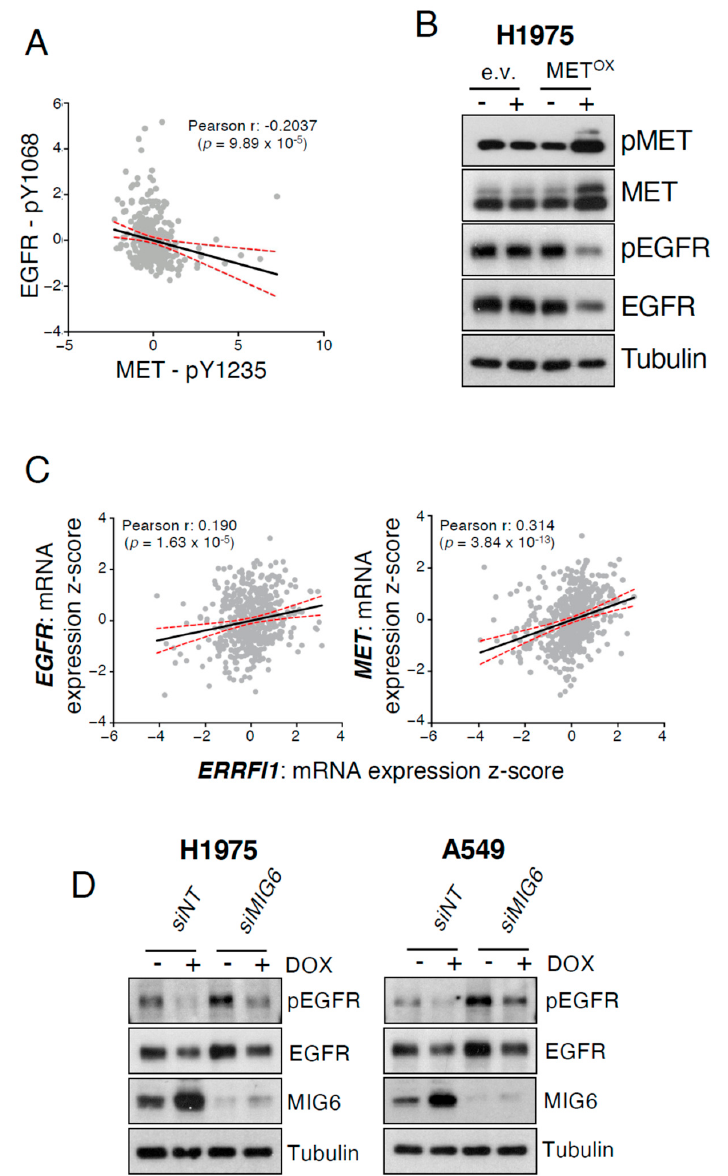
Figure 2. MET expression decreases EGFR activity. ( A ) Correlation analyses of pMET and pEGFR expression status (Z-scores) in 360 patients from the Lung Adenocarcinoma (TCGA, PanCancer Atlas) dataset. Data were analyzed by Pearson coefficient analysis (r = − 0.2037). Linear regression (black line) and 95% confidence intervals (dashed red lines) are also indicated. ( B ) Immunoblotting of the indicated proteins in H1975 cells infected with lentiviral particles harboring the doxycycline-inducible MET construct (METOX) or empty vector (e.v.). Cells were incubated (+) or not ( − ) with 1 μ g/mL of doxycycline for 48 h. This is a representative example of an experiment performed twice. ( C ) Correlation analyses for EGFR vs. ERRFI1 (MIG6 gene) and MET vs. ERRFI1 (MIG6 gene) mRNA expression (Z-scores) in 510 patients from the Lung Adenocarcinoma (TCGA, PanCancer Atlas) dataset. Z-scores were analyzed by Pearson coefficient analysis (r = 0.190 and r = 0.314, respectively). Linear regression (black line) and 95% confidence intervals (dashed red lines) are also indicated. ( D ) Immunoblotting of the indicated proteins in H1975 and A549 cells infected with lentiviral particles harboring the doxycycline-inducible MET construct (METOX) and transfected with non-targeting siRNA ( siNT ) or siRNA targeting MIG6 ( siMIG6 ). Cells were incubated (+) or not ( − ) with 1 μ g/mL of doxycycline for 48 h. This is a representative example of an experiment performed twice.